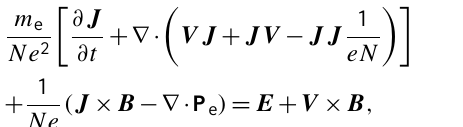
Fig. 2. Incoherent radar spectra measured with the 42m ESR radar on 1 August 2007. The full time resolution of 6s is used and the starting times for each integration are shown for 5 adjacent height gates, which are centered at the altitudes indicated. The x -axes show frequency and the y -axes show range corrected power spectral density in arbitrary units (common for all spectra). The spectra at 00:43:00UT over a longer height range are shown in the right panel of Fig.